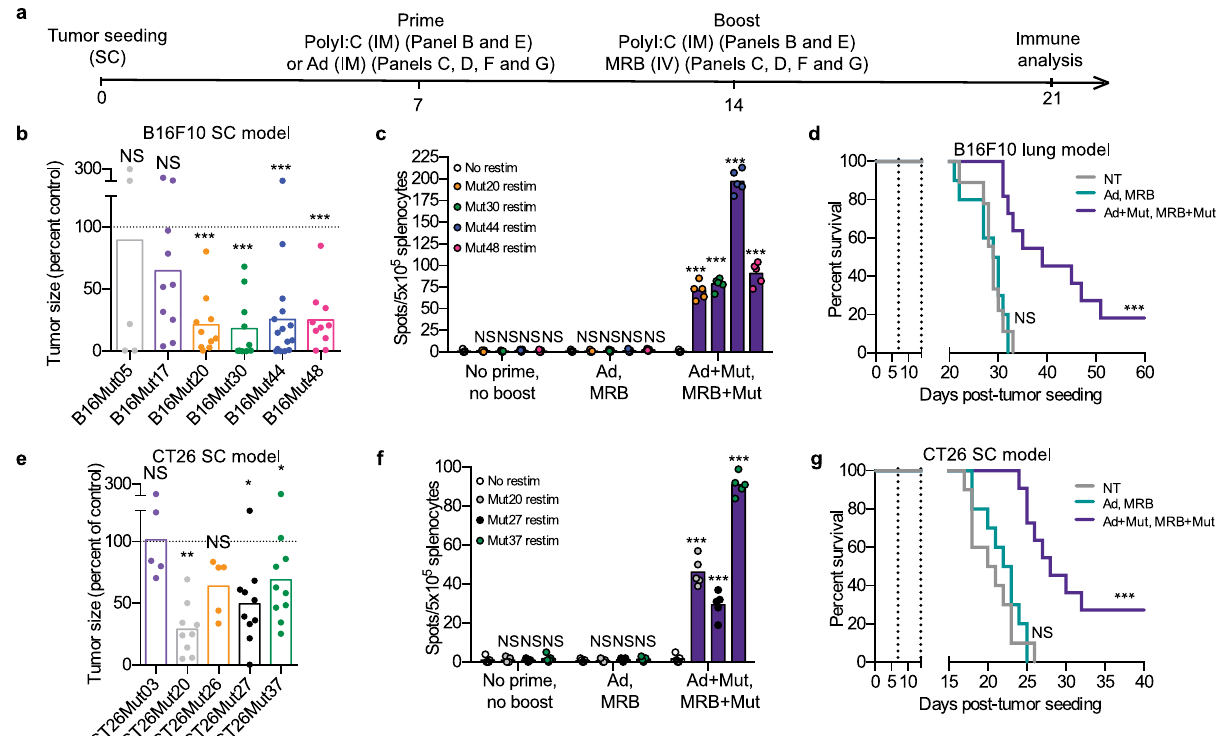
Fig. 6 Adjuvant OV vaccination against Muts improves outcome. a Treatment schedule used in this study. b Mice bearing established SC B16F10 tumors were treated IM with polyI:C and the indicated peptide on days 7 and 14 post-tumor seeding. All tumors were measured on day 21. The tumor volumes are expressed as relative to the average tumor volume of control mice (treated with polyI:C only) (from left to right; n = 5, 10, 10, 4, 10, 15 and 10). NS: p > 0.05, ***: p < 0.001 (unpaired two-tailed t -test). c IFN γ ELISPOT ( n = 5) and ( d ) Kaplan – Meier survival analysis ( n = 10) of B16F10 lung tumor-bearing mice treated with Ad and MRB or Ad and MRB co-administered with B16Mut20, B16Mut30, B16Mut44 and B16Mut48. ELISPOT: NS: p > 0.05, ***: p < 0.001 (unpaired two-tailed t -test) and survival: NS: p >0.05, ***: p <0.001 (Mantel – Cox test, two-sided). e Mice bearing established SC CT26 tumors were treated and analyzed as in ( b ) (from left to right; n = 9, 5, 5, 10 and 10). NS: p > 0.05, *: p < 0.05 (unpaired two-tailed t -test). f IFN γ ELISPOT ( n = 5) and ( g ) Kaplan – Meier survival analysis ( n = 10) of SC CT26 tumor-bearing mice treated on days 7 and 14 post-tumor seeding with Ad and MRB or Ad and MRB co- administered with CT26Mut20, CT26Mut27 and CT26Mut37. ELISPOT: NS: p > 0.05, ***: p < 0.001 (unpaired two-tailed t -test) and survival: NS: p >